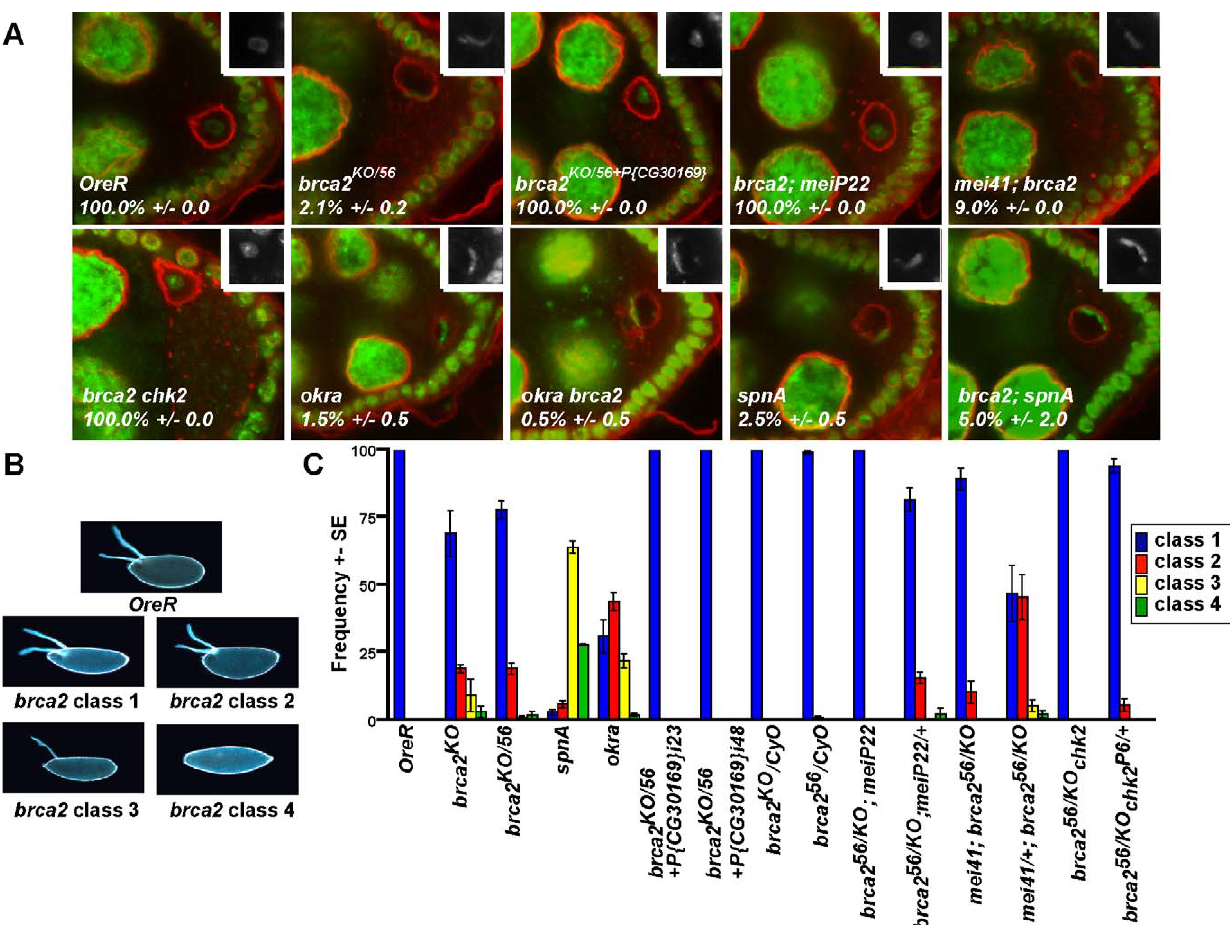
Figure 2. Persistent Double-Stranded Breaks in brca2 Mutants Activate the Meiotic Recombination Checkpoint (A) Egg chambers stained for DNA (green) and membranes (red). Percentage shown is the average number of wild-type-like, spherical karyosomes from two independent experiments with a total of 175–200 nuclei counted. Insert shows the region containing the oocyte nucleus. (B) Eggshells laid by wild-type and brca2 KO/56 mutant females. (C) Frequency of the different classes of eggshells laid by females fed yeast for 3–4 days. Class 1 eggs have two separate dorsal appendages and appear wild-type with respect to dorsal patterning. Class 2 eggs have 2 dorsal appendages that are fused at the base. Class 3 eggs have a single dorsal appendage. Class 4 eggs have no dorsal appendages and represent the complete loss of dorsal fate. Error bars represent the standard error between 3 independent experiments. Total number of eggs counted per genotype was between 500 and 3,000 eggs. P f CG30169 g i23 and P f CG30169 g i48 are genomic rescue constructs inserted at two different chromosomal